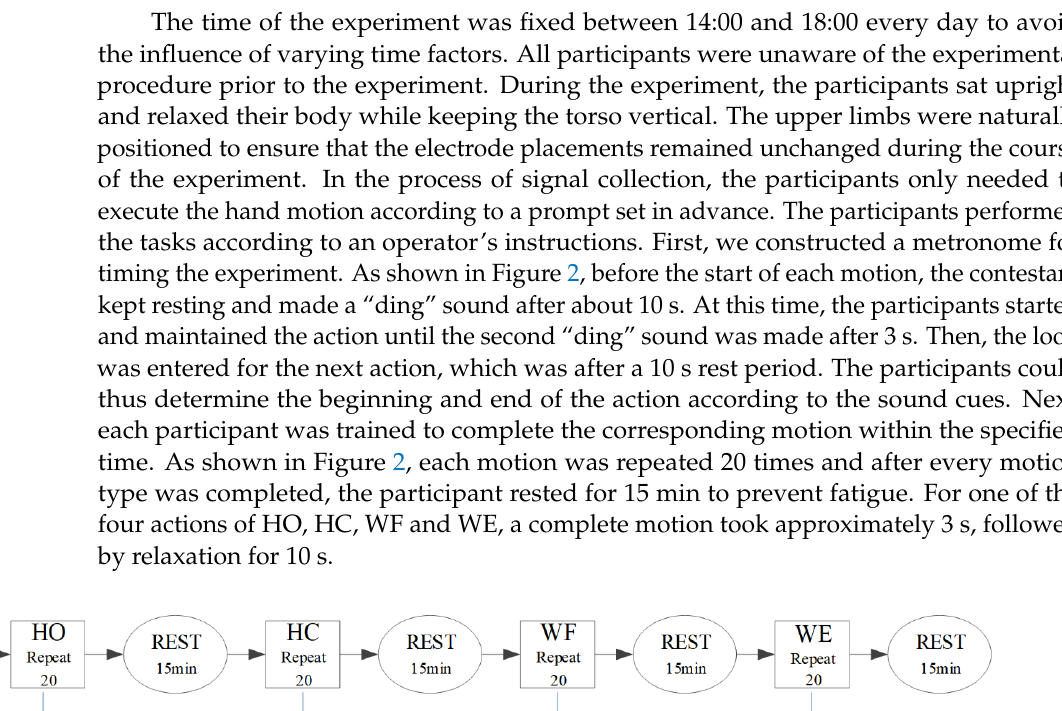
Figure 3. Electrode placement for ( a ) EEG, ( b ) EMG. FDS: flexor digitorum superficialis; BR: brachi ‐ oradialis; BB: biceps brachii; ED: extensor digitorum; FCU: flexor carpi ulnaris; ECU: extensor carpi ulnaris. As shown in Figure 3a, EEG data were recorded by a digital EEG apparatus (g.MOBllab +MP − 2015) at the following eight positions of the 10–20 systems: Cz, C3, C4, Cp1, Cp2, FC3, FC4, and Fz (Fpz was selected as the grounding electrode). Considering that all the subjects were right ‐ handed, some of the electrodes were only placed in the left brain region to build a much leaner function network. These signals were sampled at 1000 Hz. Alcohol was used to wipe and clean the mus ‐ cle area before electrode placement. The EEG and EMG signals were collected synchronously by means of a trigger. The EEG signals were bandpass ‐ filtered at 0.05–100 Hz, whereas the EMG signals were band ‐ pass ‐ filtered at 30–200 Hz. The EEG artifacts caused by blinking or eye movement were removed through independent component analysis (ICA). We rejected a total of two com ‐ ponents during the analysis of the ICA algorithm. A 50 Hz notch filter was used to elimi ‐ nate the power ‐ line interference. The EMG signals were full ‐ wave ‐ rectified [35]. Finally, the signals were organized into a time series of 3000 data points (3 s).